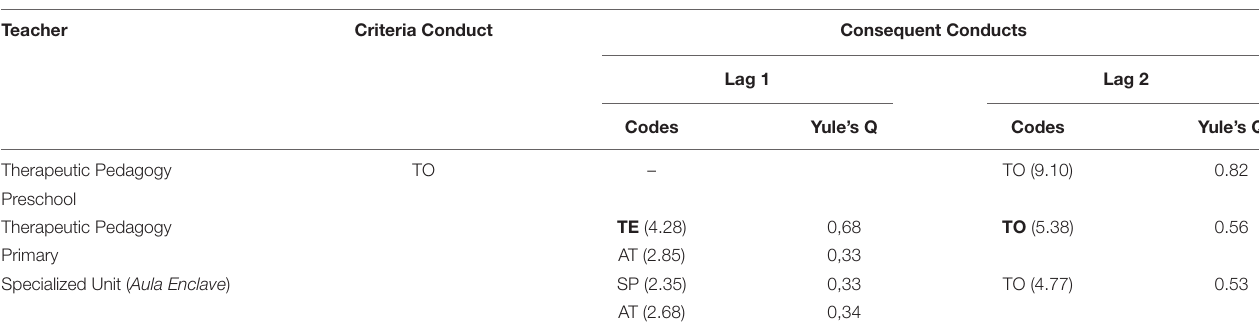
TABLE 6 | Organization